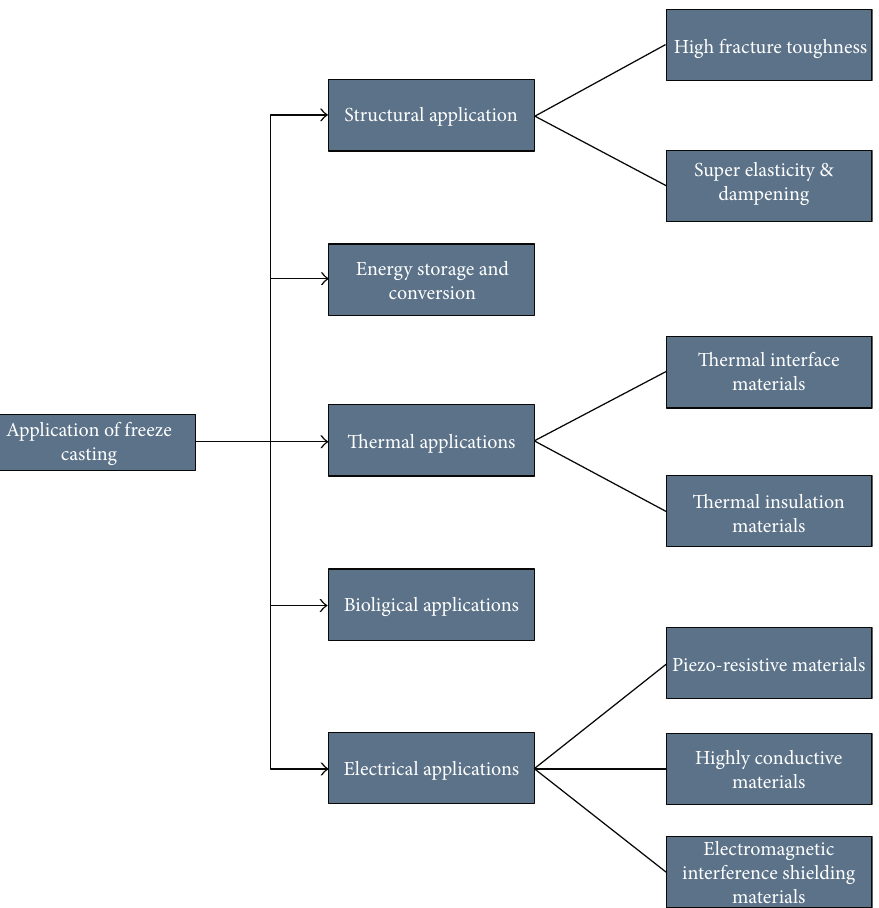
Figure 8: Applications of freeze